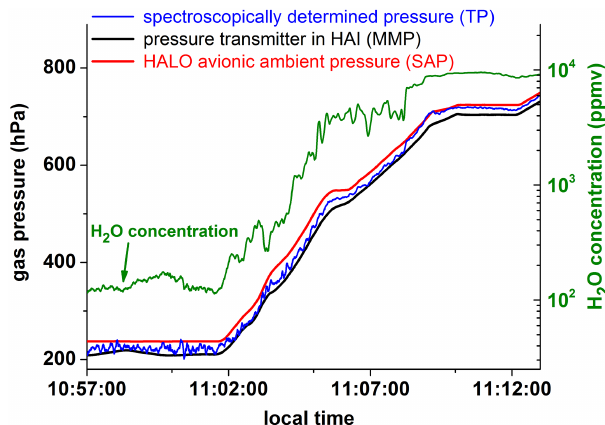
Figure 8. Superposition of all three pressure measurands (bottom traces, left scale) as well as the measured water vapour profile (top trace and right scale) vs. time during an aircraft descent from 200 to 800hPa. Despite the micro-mechanical HAI pressure transmit- ter (MMP, black) being placed very close to the open-path mea- surement volume, clear discrepancies compared to the other pres- sure sensors are visible. These are attributed to the high-speed flow around the HAI sensor and especially towards the rectangular pres- sure transmitter interface (see Fig. 6), which can cause complex dy- namic effects depending on the HAI orientation in the flow. The red curve shows static ambient pressure measurements (SAP) from HALO’s avionic sensors (Giez, 2012), located “in front” of Halo in the nose boom. The typical large atmospheric H 2 O concentra- tion variations (log scale) are visible, indicating the necessity for detailed corrections of the optical pressure measurement (explained in detail in